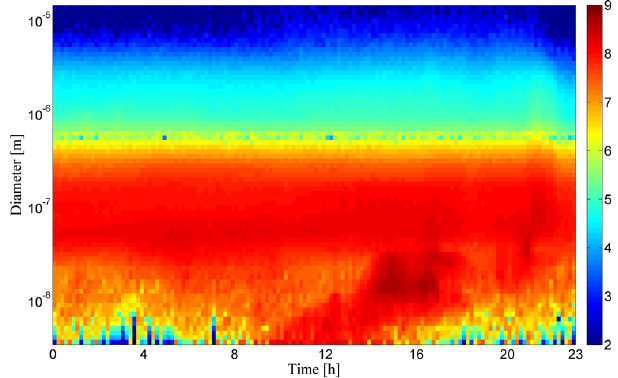
Fig. 1b. As in Fig. 1a, but for combined state ( x N com ) .